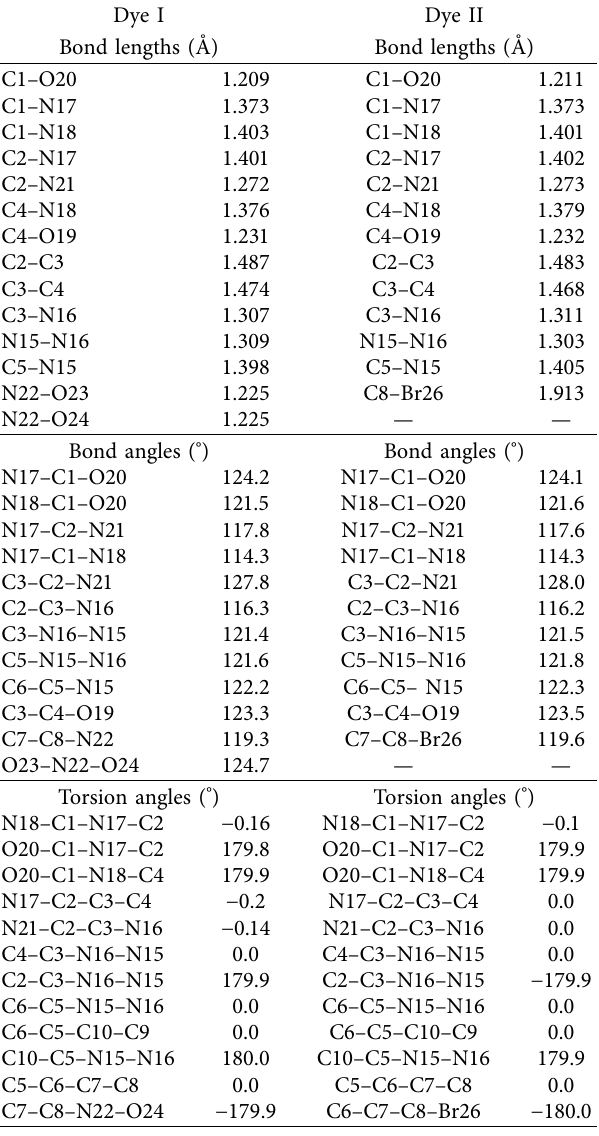
311++G(d,p) method for imine-diketo-hydrazone (T-V) forms of dyes I and